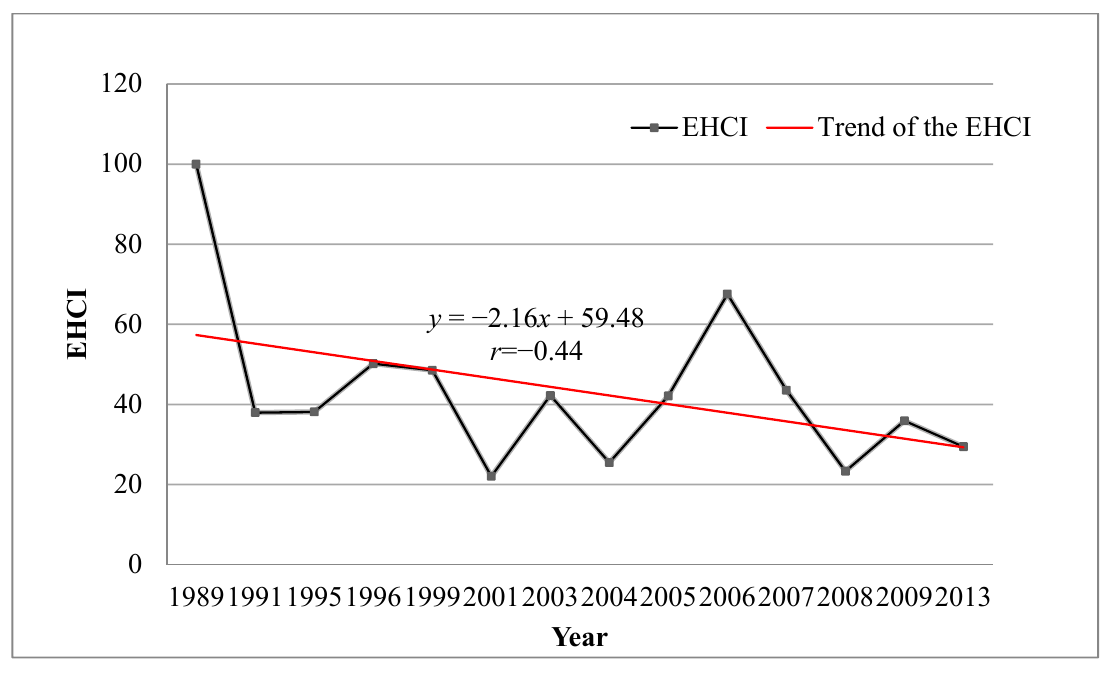
Figure 5. The EHCI of the Poyang Lake wetland and its trend during 1989–2013.